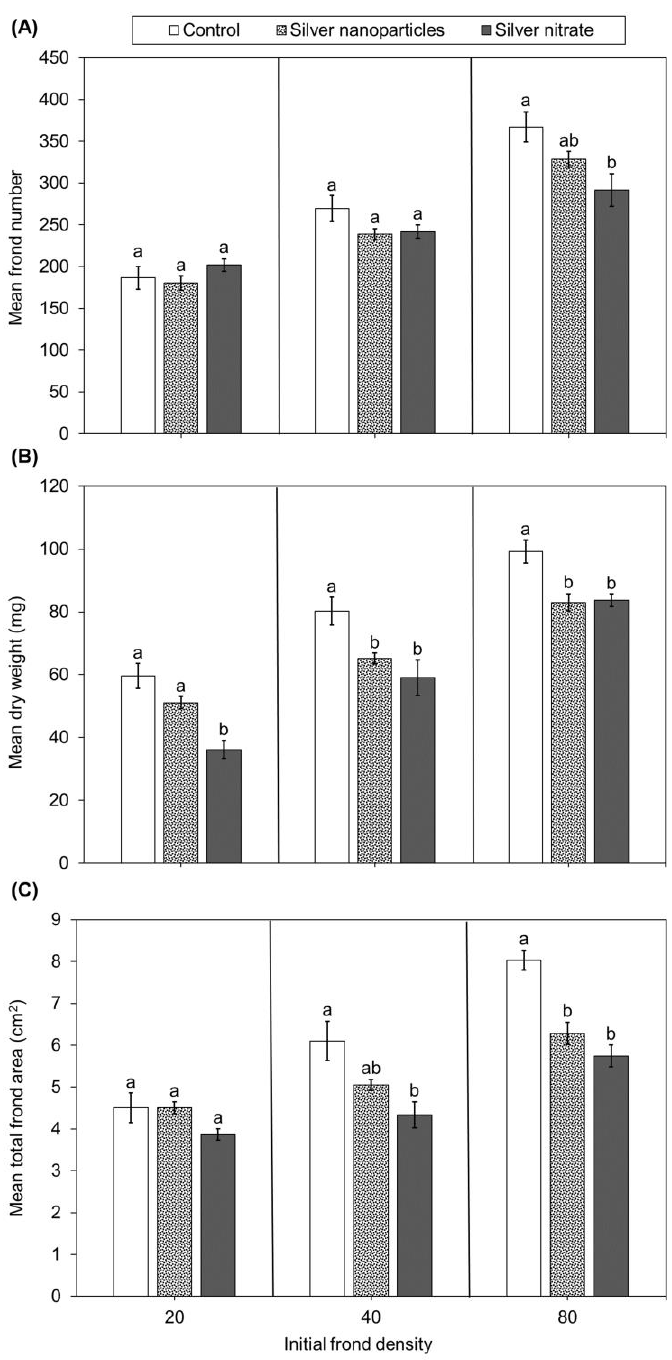
Figure 1. Mean ± standard error frond number ( A ), dry weight ( B ), and frond area ( C ) of Lemna minor after 14 days in control, 500 µ g/L AgNPs, or 500 µ g/L AgNO 3 ( n = 5) at different frond densities (20, 40, and 80 fronds per 28.5 cm 2 ). Different letters indicate differences among treatments within initial frond density groups (one − way ANOVA, Tukey multiple comparisons tests, p <